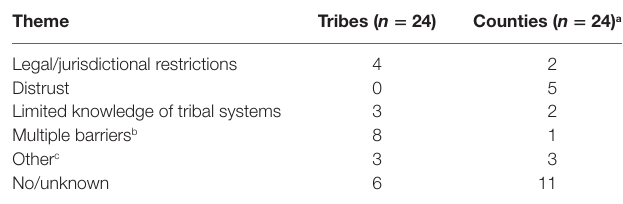
Table 3 | Tribe- and county-reported barriers to CJS by